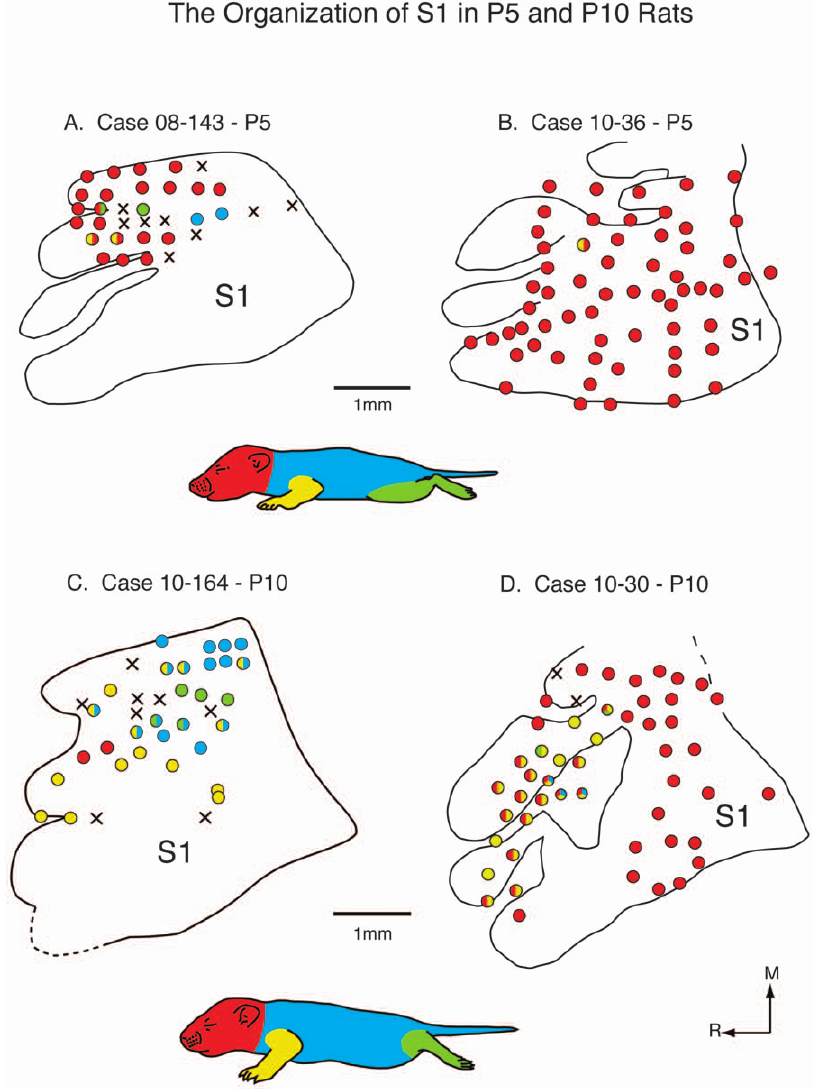
Figure 8. Functional S1 maps in P5 and P10 rats. Reconstructed functional maps of primary somatosensory cortex in P5 (A and B) and P10 (C and D) rats. A schematic of a rat body is divided into different major sections: the head, portions of the face and the vibrissae are red, the trunk and tail are blue, the forelimbs are yellow, and the hindlimbs are green. Recording sites that contained neurons that had receptive fields on these major parts are shown as circles filled with that color (i.e., yellow). Recording sites that contained neurons that responded to multiple body parts are labeled with the colors of all of the corresponding body parts. Recording sites that did not respond to any somatosensory stimulation are marked with an X. At P5, medial portions of S1 that normally represent portions of the limbs and trunk contain representations of the face/vibrissae with only a few sites containing neurons responsive to stimulation of the contralateral body. By P10, representations of body parts are beginning to emerge. Conventions as in previous figures.